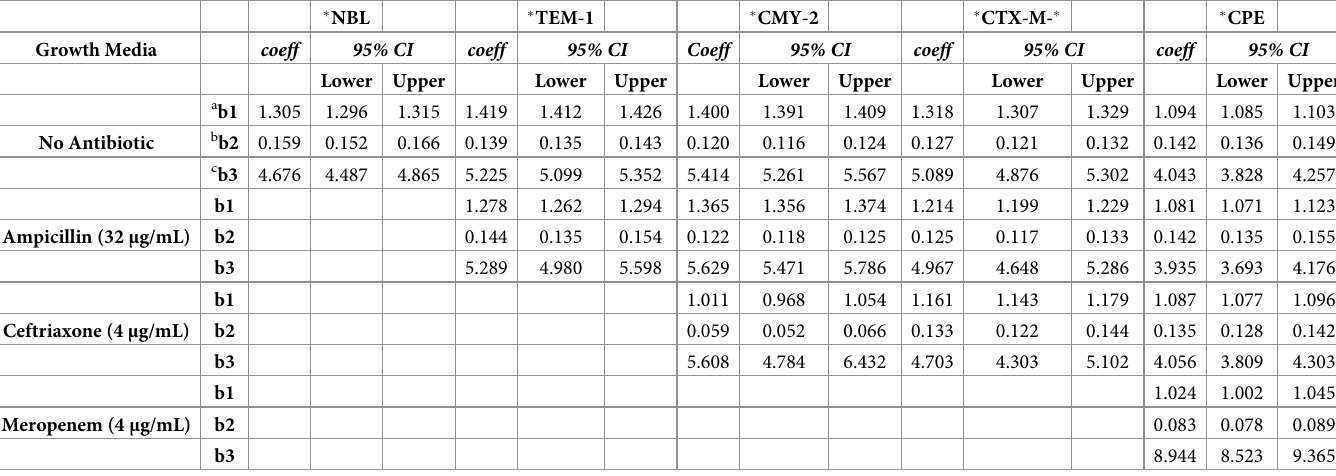
Table 2. Bacterial growth curve parameter values with 95% confidence intervals as estimated by a 3-parameter Gompertz non-linear model, across resistance gene group and by antibiotic type.